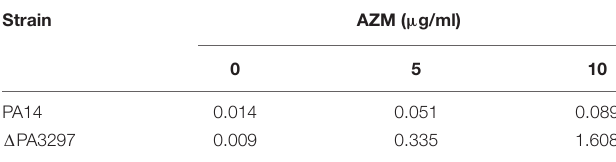
The unprocessed 23S-5S rRNA ratios were calculated according to the equation: Ratio = (1 + e 23S ) C t(23S) /(1 + e 23S-5S ) C t(23S-5S) ; e: Amplification efficiency. C t : Cycles when fluorescence intensity reaches detection